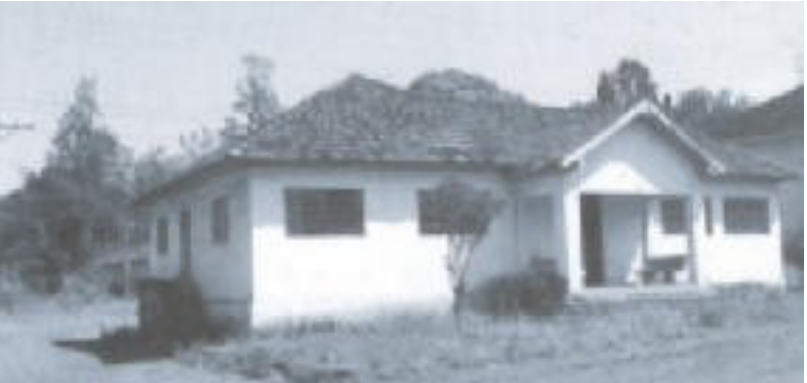
Figure 2. Building of the Department of Zoology in the University of Rio Claro in the late 1960’s, where F. Matthiesen did his work.